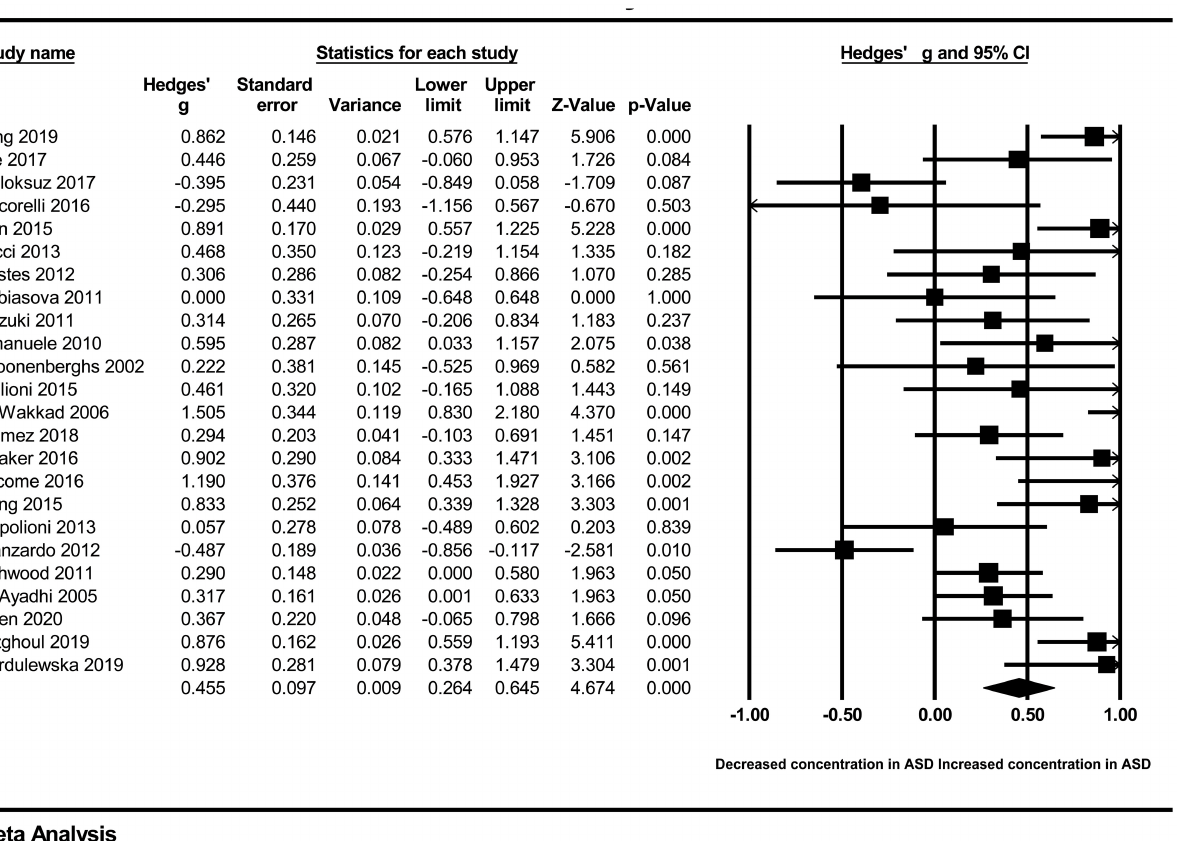
FIGURE 2 | Forest plot for the random-effects meta-analysis